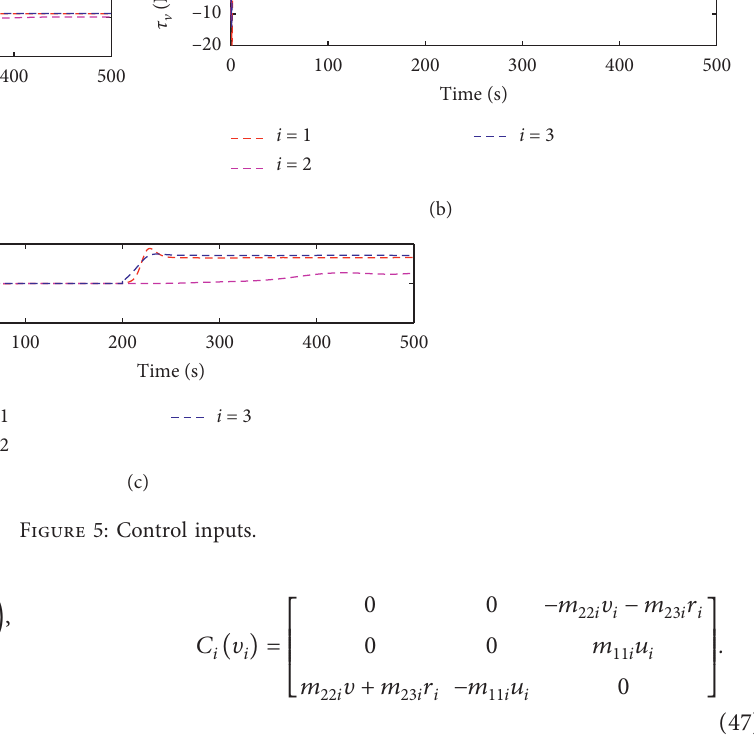
Figure 5: Control